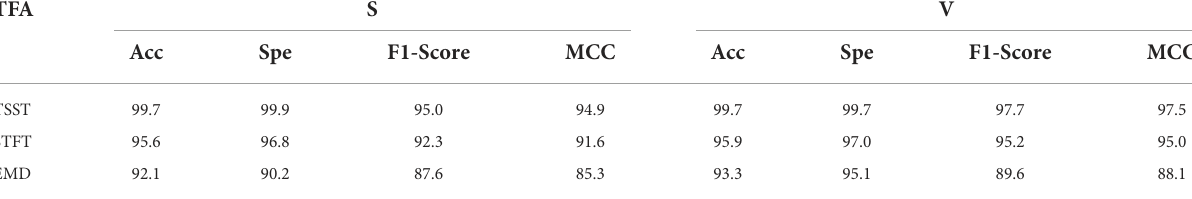
TABLE 5 Comparison results of TSST-, STFT- and EMD-based ConViT methods.